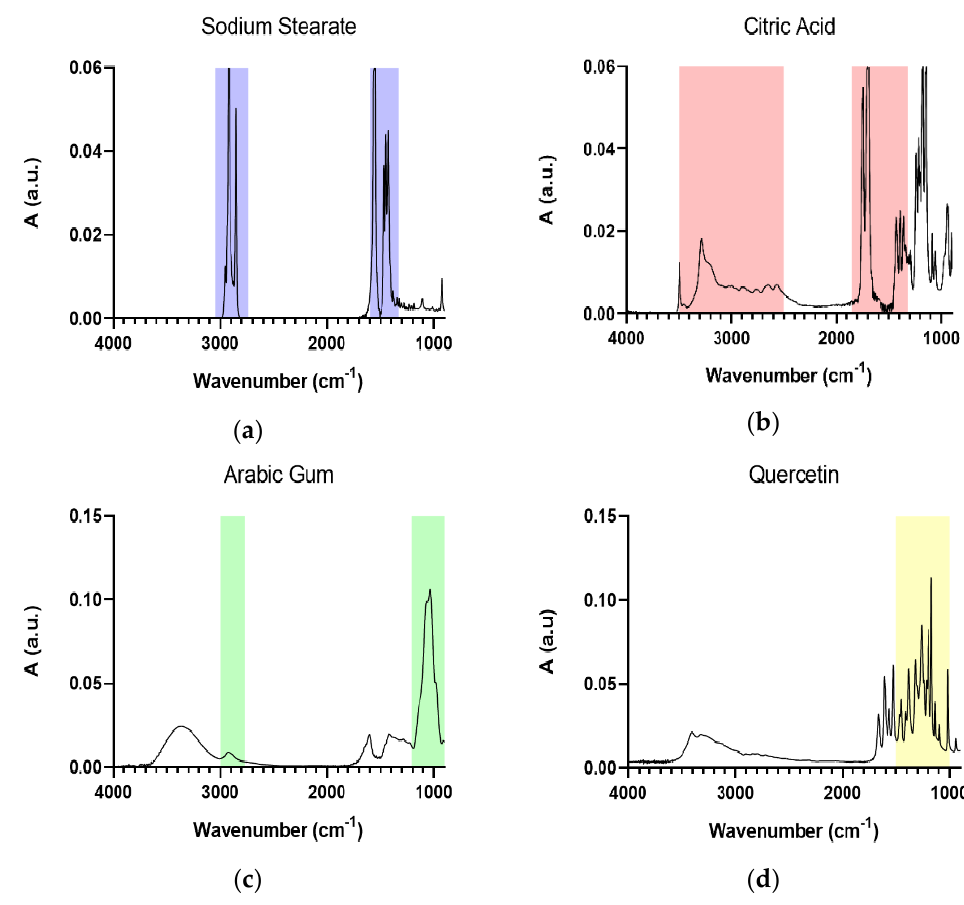
Figure 3. IR spectra of SLNs’ main components: Sodium Stearate ( a ), Citric Acid ( b ), Arabic Gum ( c ), and Quercetin ( d ). Distinctive signals are highlighted.